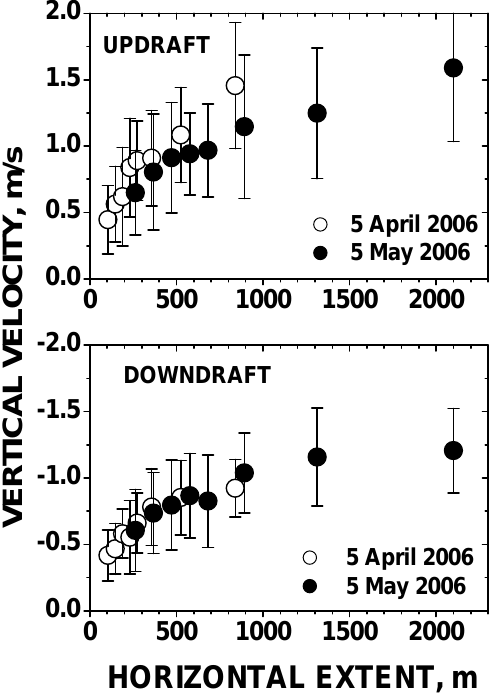
Fig. 10. Updraft mean (top) and downdraft mean vertical velocity (bottom) as a function of draft horizontal extent (temporal length of the observed updraft and downdraft periods times horizontal wind speed). Average values (symbols) and standard deviations (verti- cal bars) are presented for eight occurrence duration intervals